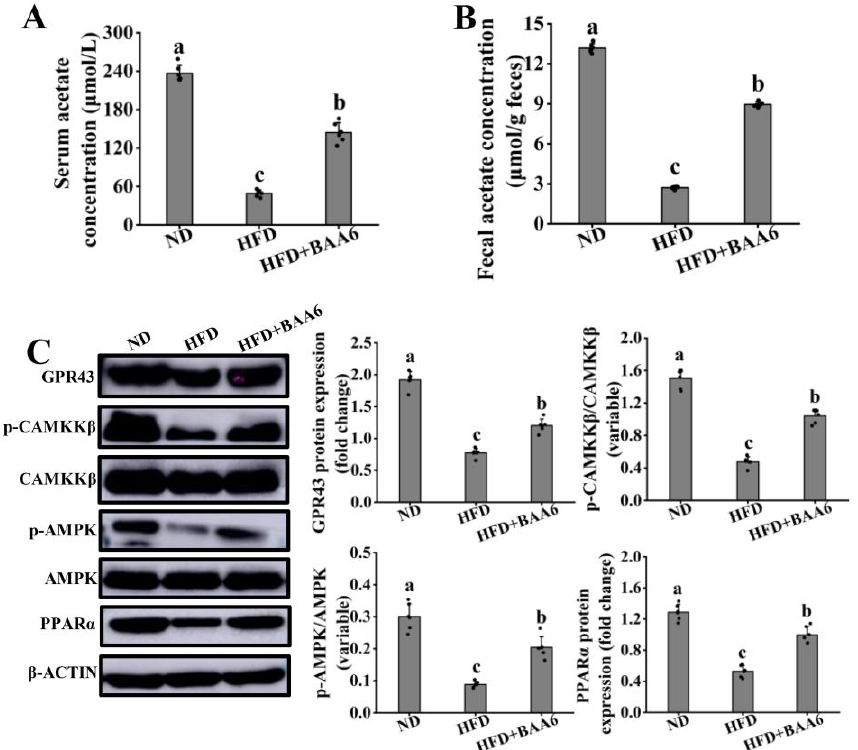
Figure 8. Effect of BAA6 administration on GPR43-PPARα signaling of epididymal adipose tissues in HFD-fed mice. Acetate concentration in serum ( A ) and feces ( B ). ( C ) Western blot results of GPR43, p-CAMKKβ, p-AMPK, and PPARα, following daily treatment with 10 9 CFU/kg of BAA6. Values are shown as means ± SD ( n = 6). Different lowercase letters mean remarkable differences between groups at p < 0.05.